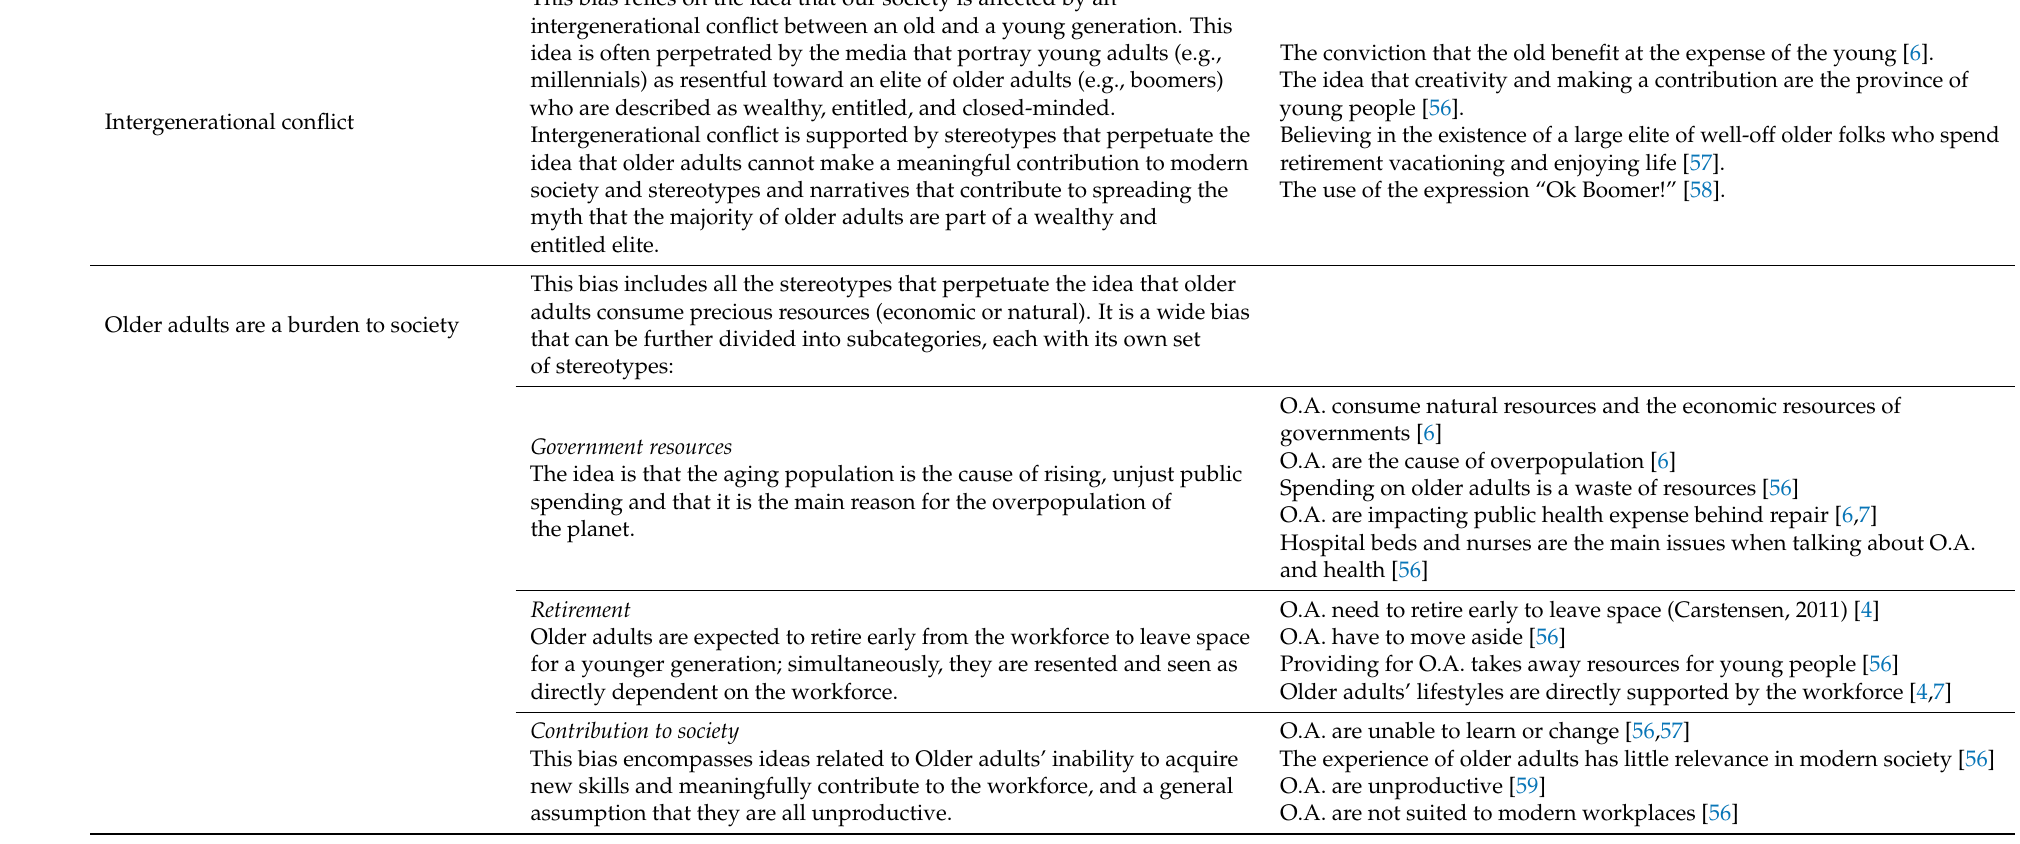
Intergenerational